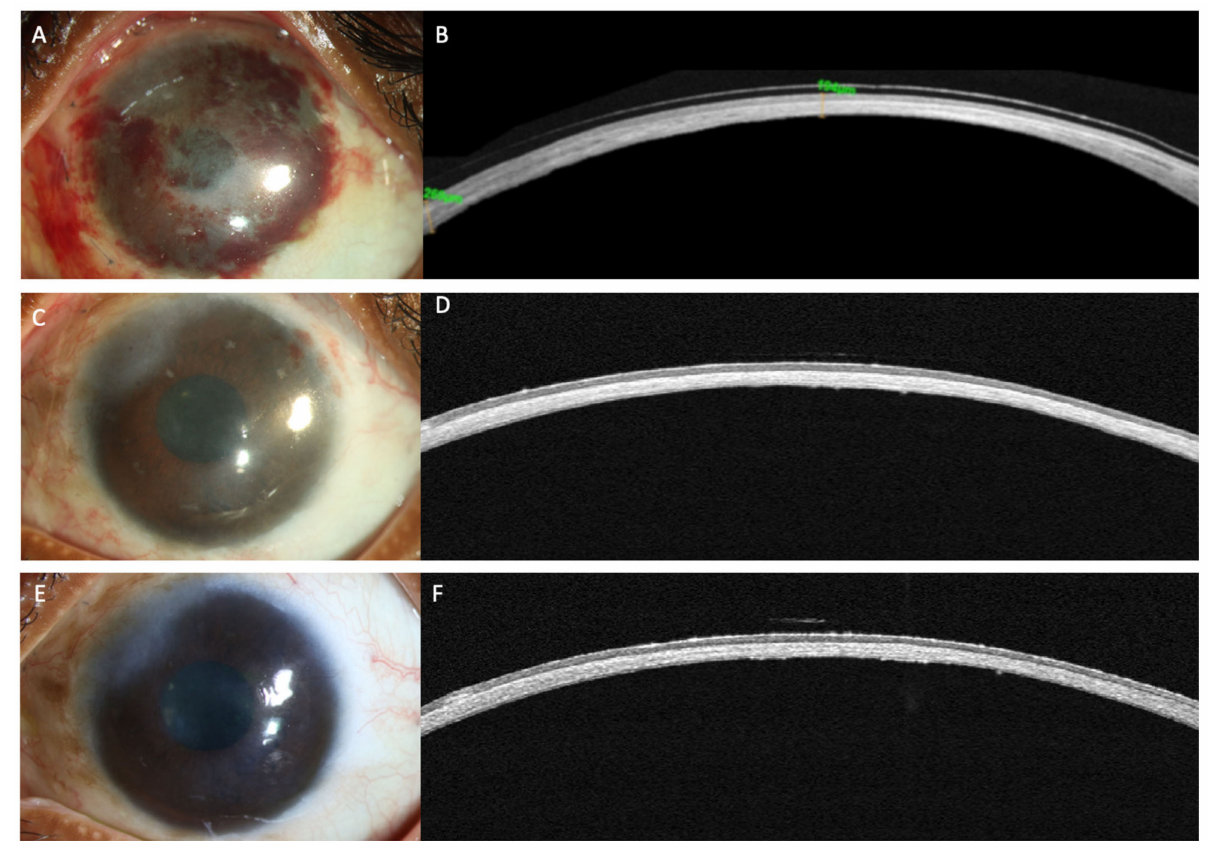
Figure 3. ( A – F ) This is a collage of images depicting recovery following simple limbal epithelial trans- plantation (SLET) in the patient from Figure 2. ( A , B ) Slit lamp image and the corresponding optical coherence tomography (OCT) image captured in the immediate postoperative period illustrating thinning of the corneal stroma with absence of the hyperreflective conjunctival epithelium. ( C ) The surface is well epithelialized, six weeks after SLET with stromal thinning evident on the OCT scan along with a normal hypo-reflective corneal epithelium ( D ) The stable ocular surface is maintained 5 months after the surgery ( E , F